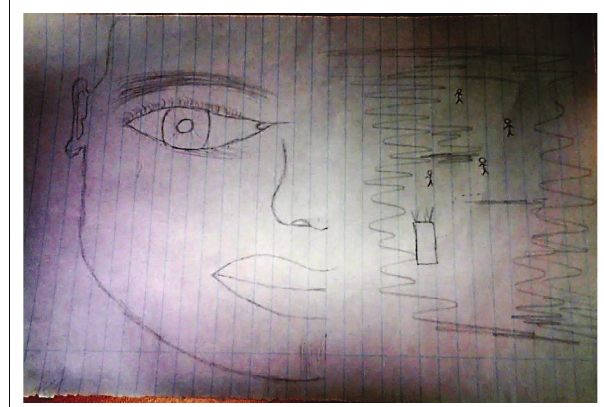
FIGURE 1: Drawing of Dream 6, the half-face